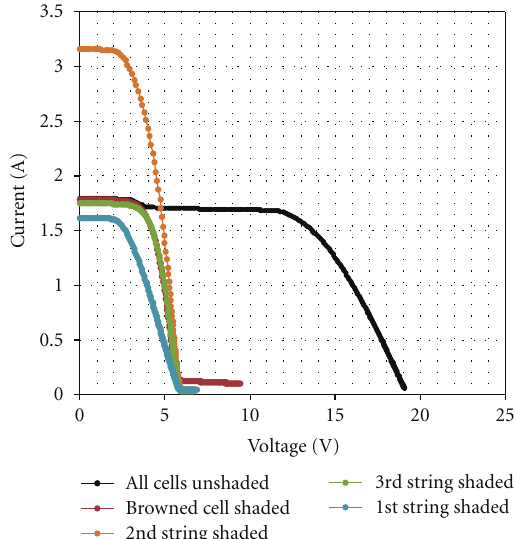
Figure 11: I-V curves obtained from the aged SIEMENS M55 PV module under the various